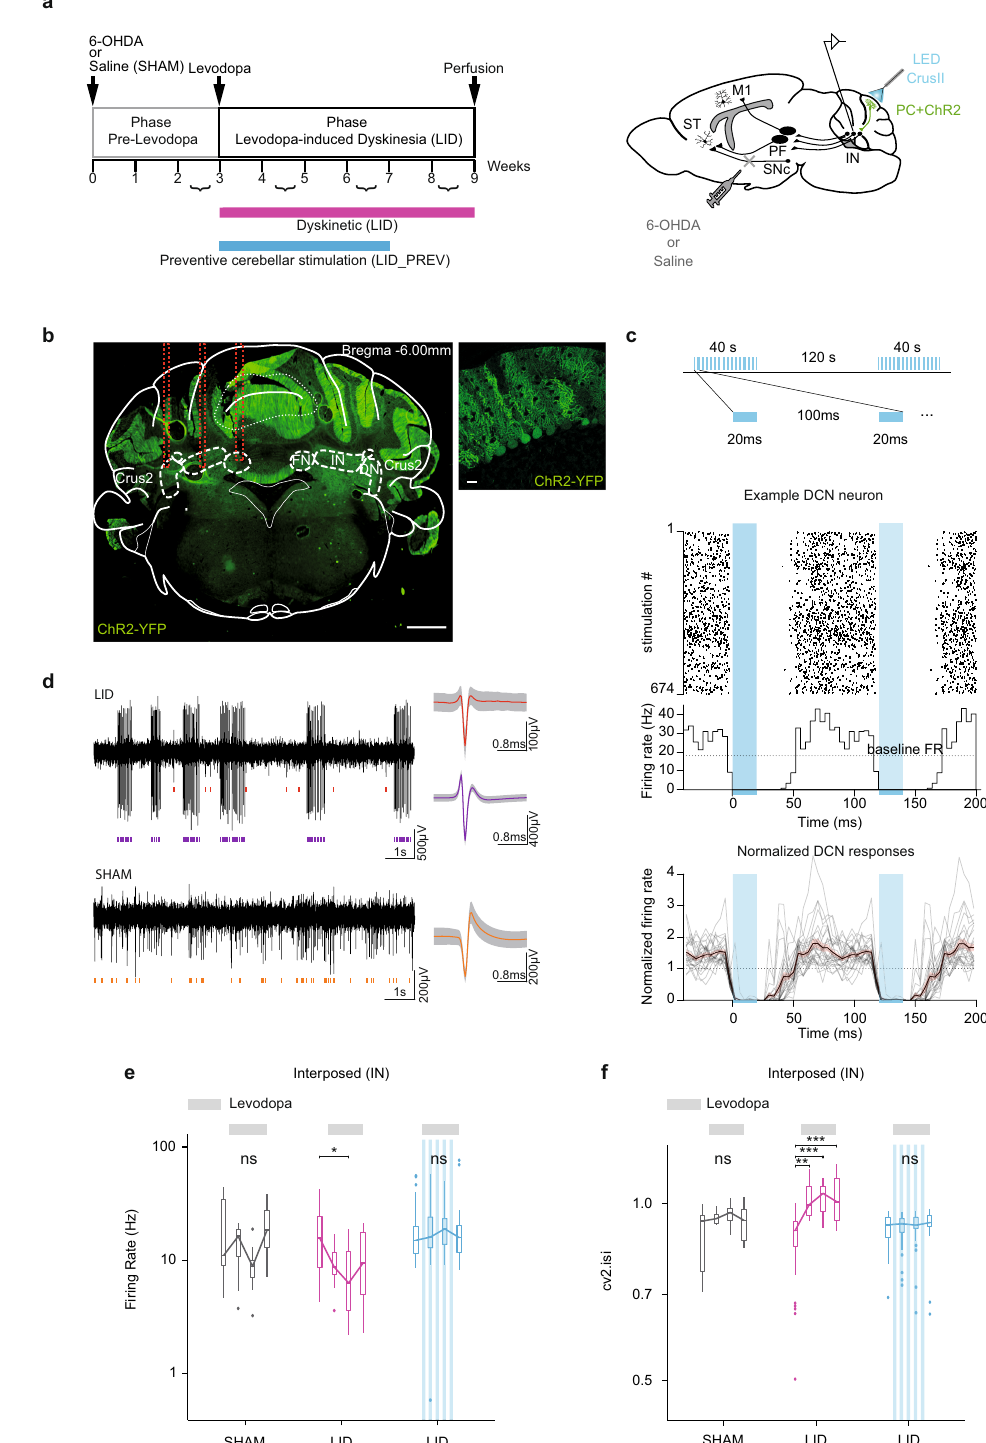
Purkinje cell stimulation over CrusII prevents the erratic activity of the interposed nucleus observed in LID mice . The irregularity of neural discharge in the cerebellum is detrimental to motor control 70 and has been observed in rapid-onset dystonia- Parkinsonism 71,72 and tremor 73 . The average normalized differ- ence of successive interspike intervals (cv2.isi) is a measure of irregularity of directly adjacent interspike intervals, and therefore